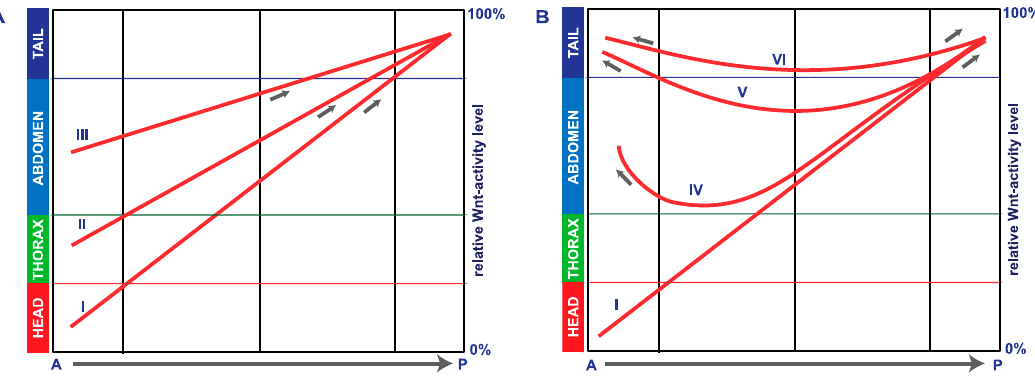
Figure 6. Schematic illustration of Wnt activity along the AP-axis in wild-type- and RNAi-embryos. ( A ) Wnt activity along the anterior-posterior axis is graded from low to high in the wild-type embryo (curve I) resulting in the formation of all pattern elements head, thorax and abdomen. Upon Tc-axin -RNAi (weak effect) or LRP4-RNAi, Wnt activity at the anterior becomes de-repressed and thus is elevated in the anterior egg to a level that is not compatible with head- (curve II) nor head/thorax development (curve III). AP-polarity, however, remains normal due to the graded distribution of Wnt activity. ( B ) Embryos that not only miss anterior structures but in addition show development of posterior fate at the anterior pole (curves IV–VI) observed in RNAi experiments knocking down Tc-axin alone or in combination with either Tc-wnt8 or Tc-arrow . Such embryos developed polarity reversal of only few abdominal bristles or abdominal segments with reverse polarity at the anterior (curve IV) or a mirror image double abdomen phenotype (curve V). Two opposing hindguts connected by a small cuticle were seen predominantly in the combinatorial RNAi experiments (curve VI), the Wnt-flat HIGH situation.